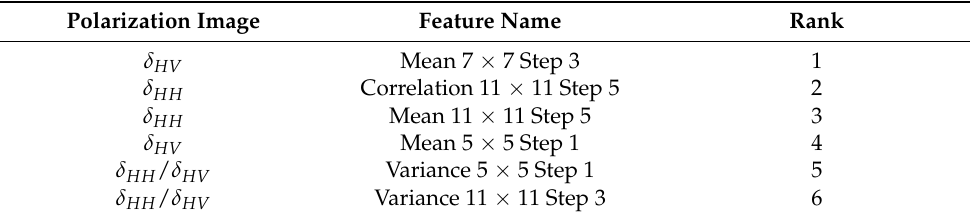
Table 1. The top six co-occurrence matrix (GLCM)-derived texture features produced according to their averaged importance by random forest.